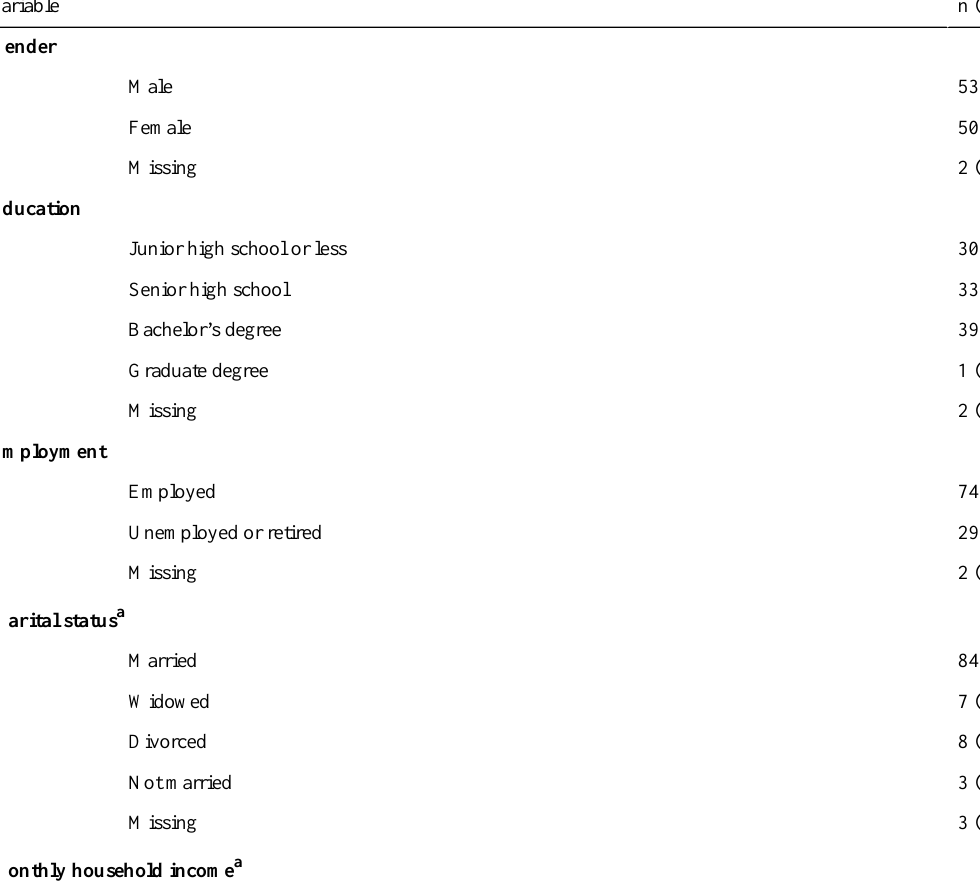
Table 4. Descriptive statistics on sample demographics